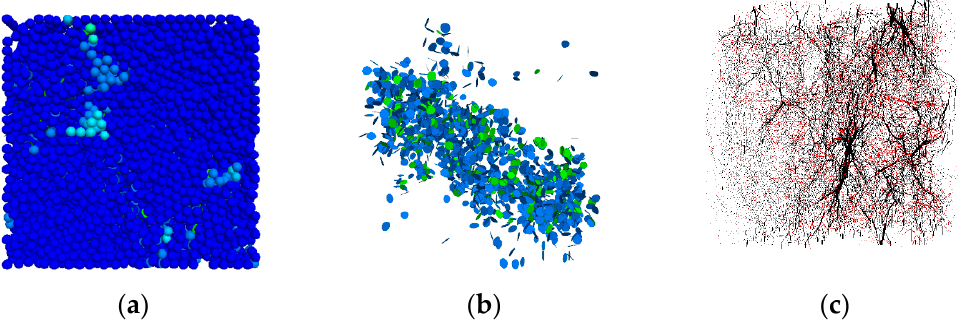
Figure 23. The failure mode of the foamed concrete with a density of 600 kg/m 3 at a loading rate of 0.06 mm/min. ( a ) model failure mode; ( b ) crack development; ( c ) force-chain distribution.